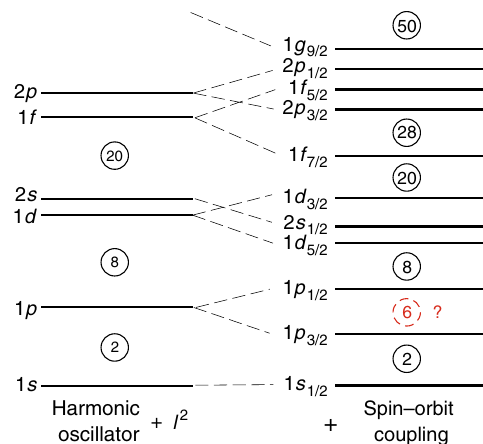
Fig. 1 Nuclear shell structure. The left diagram is the shell structure for a harmonic-oscillator potential plus a small orbital angular momentum ( l 2 ) term. The right diagram shows the splitting of the single-particle orbitals by an additional spin – orbit coupling